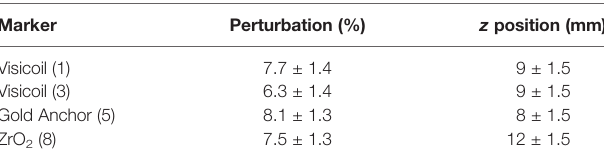
TABLE 6 | Maximum fl uence perturbation values and their position along the beam axis for the different fi ducial markers for the 170.05MeV proton beam modulated by a 2D RM.